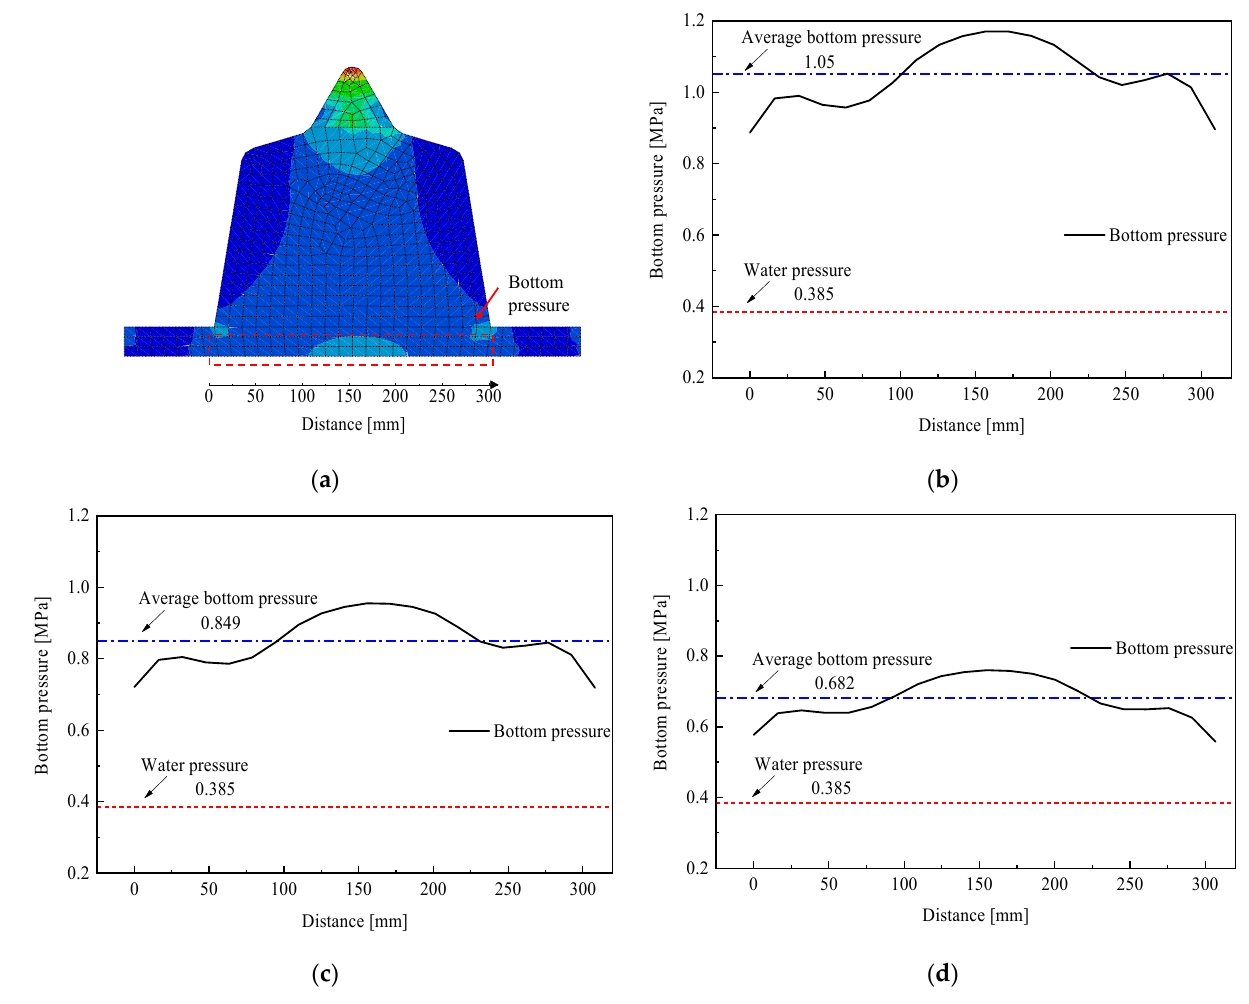
Figure 19. Bottom pressure of GINA gasket under different remaining compressions: ( a ) range of bottom pressure; ( b ) remaining compression = 108 mm; ( c ) remaining compression = 97.2 mm; ( d ) remaining compression = 86.4 mm. Table 8. Ratios of bottom pressures of GINA gasket to water